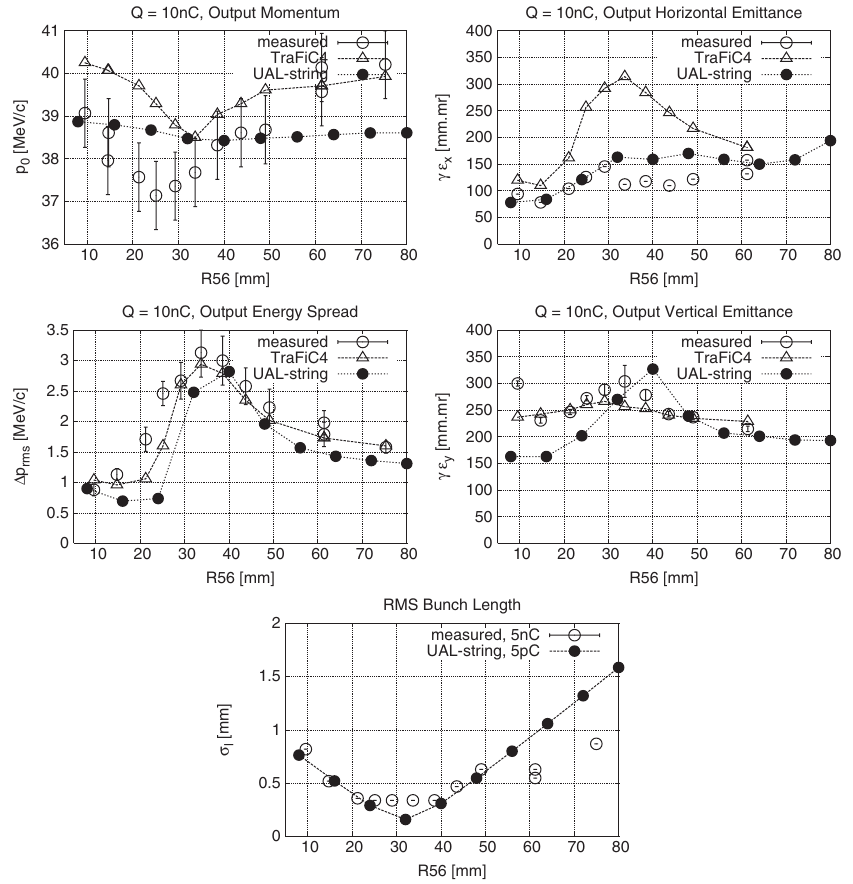
FIG. 4. Q ¼ 10 nC output distributions, otherwise the same as in Fig. 3. All these Q ¼ 5 nC and Q ¼ 10 nC plots used 1600 macroparticles. Results with as few as 400 particles were essentially equivalent. The vertical emittance measurements are considered to be ‘‘not very reliable’’ by Braun et al.